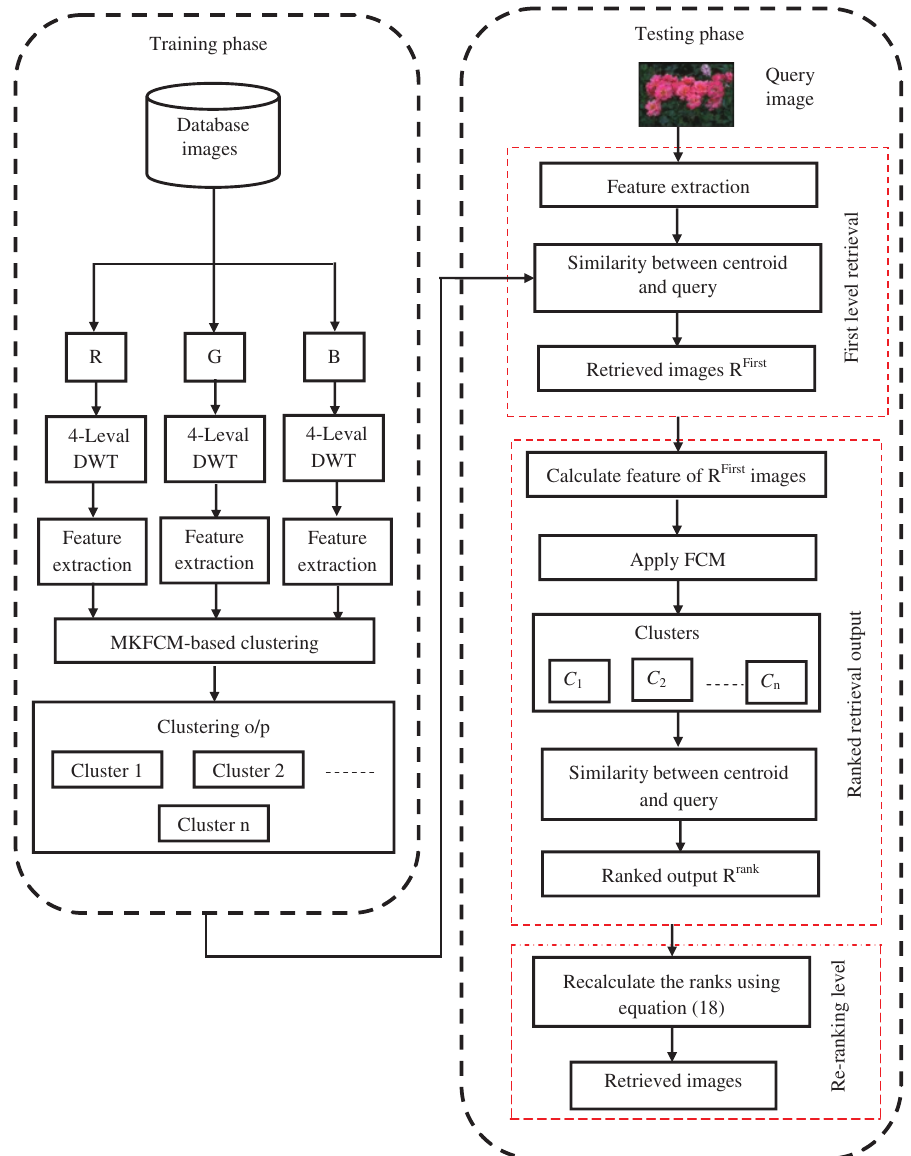
Figure 1: Overall Diagram of the Proposed Retrieval and Re-ranking